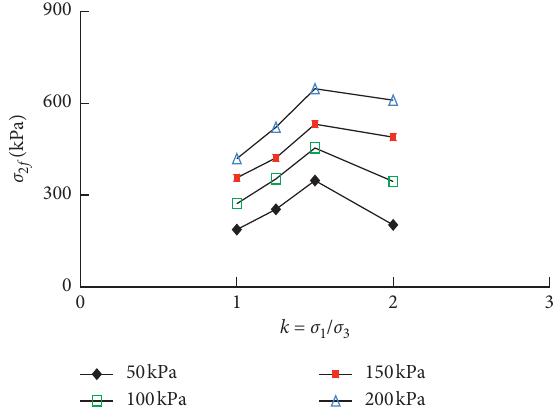
Figure 12: Change law between σ